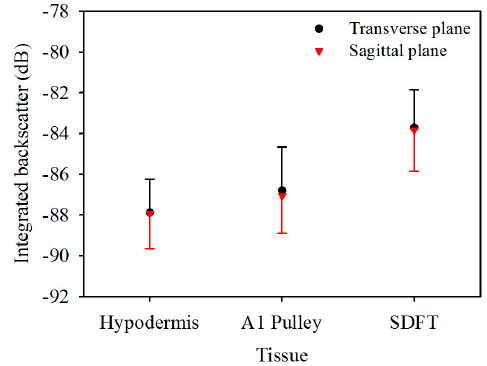
Figure 5. Integrated backscatter of hypodermis, A1 pulley, and SDFT. The error bars represent the standard deviation.